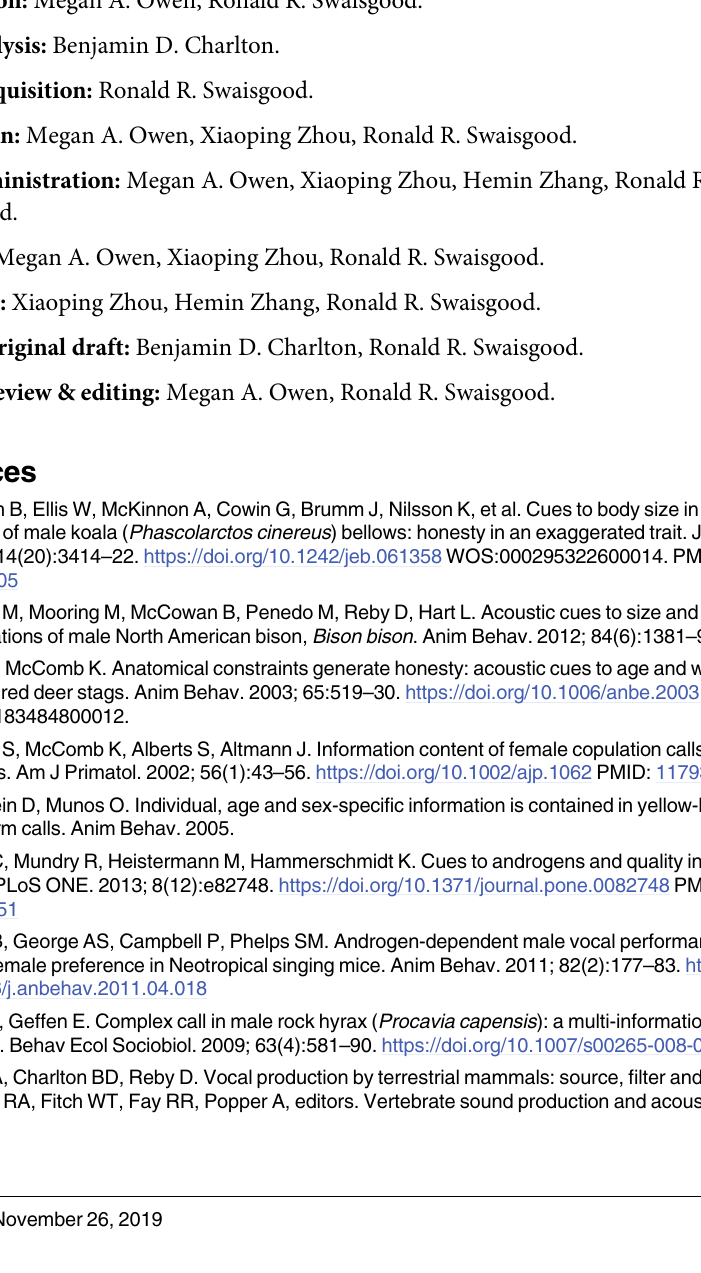
S1 Dataset. Excel spread sheet of the study